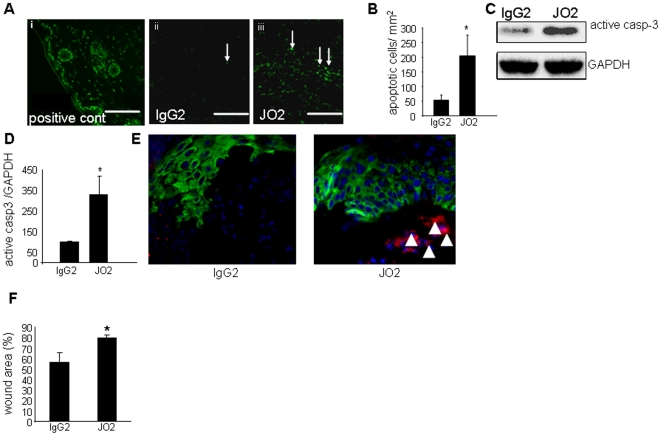
Topical application of Fas-activating anti-CD95 JO2 to the wound-site increased apoptotic cell count while not inducing apoptosis in keratinocytes.
A, visualization of TUNEL stained apoptotic cells in day 5 wound tissue treated with anti-murine CD95 (clone:JO2, 2 µg/wound) or vehicle containing isotype control (IgG2). Positive control (wound tissue treated with proteinase K and nuclease) showing TUNEL positive apoptotic cells with green nuclei stain; B, scoring of apoptotic cells in wound tissue sections stained with TUNEL. *, p<0.05 compared to the paired vehicle-treated wounds; C, a representative Western blot image of active caspase-3 (casp-3) and GAPDH (housekeeping) in tissue extracts from IgG2 or JO2 treated d3 wounds; D, densitometric data of blot shown in panel C. Data shown are mean ± SD (n = 3). *, p<0.05 compared to IgG2 treated wounds; E, JO2 treatment did not induce keratinocyte apoptosis. Keratin-14 (green), active caspase-3 (red) and DAPI (blue) stained migrating epithelial tip in placebo (left) or JO2 treated (right) wounds. Scale bar  = 20 µm. Active caspase-3 staining was observed in the granulation tissue but not in the hyper-proliferative epithelium or epithelial tip following JO2 treatment; F, wound area as percentage of initial wound determined on the day 3 after wounding. Data are shown as mean ± SD (n = 4).*, p<0.05 versus corresponding control IgG2 treated wound.